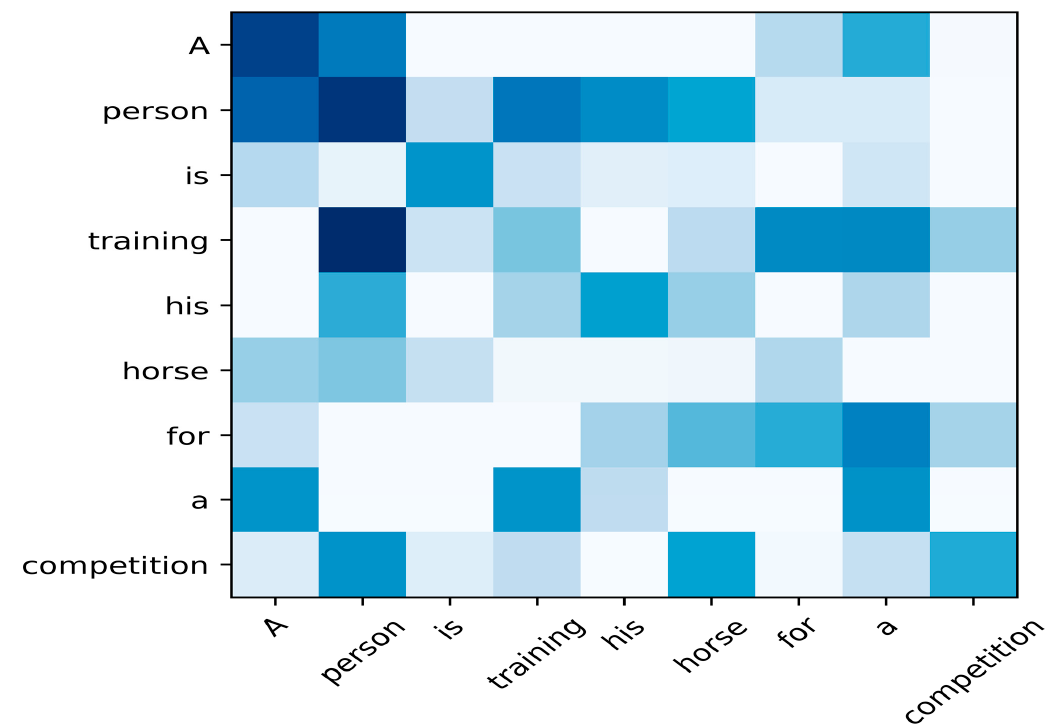
Figure 5. Semantic visualization results of the BiLSTM model.